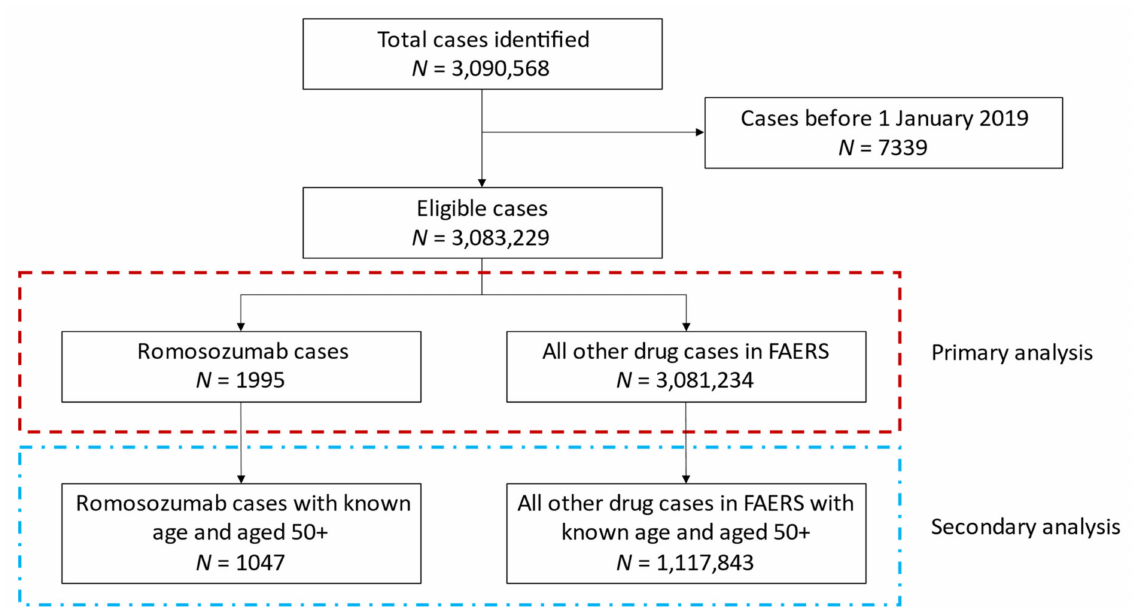
Figure 1. Study flow diagram for included cases identified from quarterly files in the US Food and Drug Administration Adverse Event Reporting System (FAERS) between 1 January 2019 and 31 December